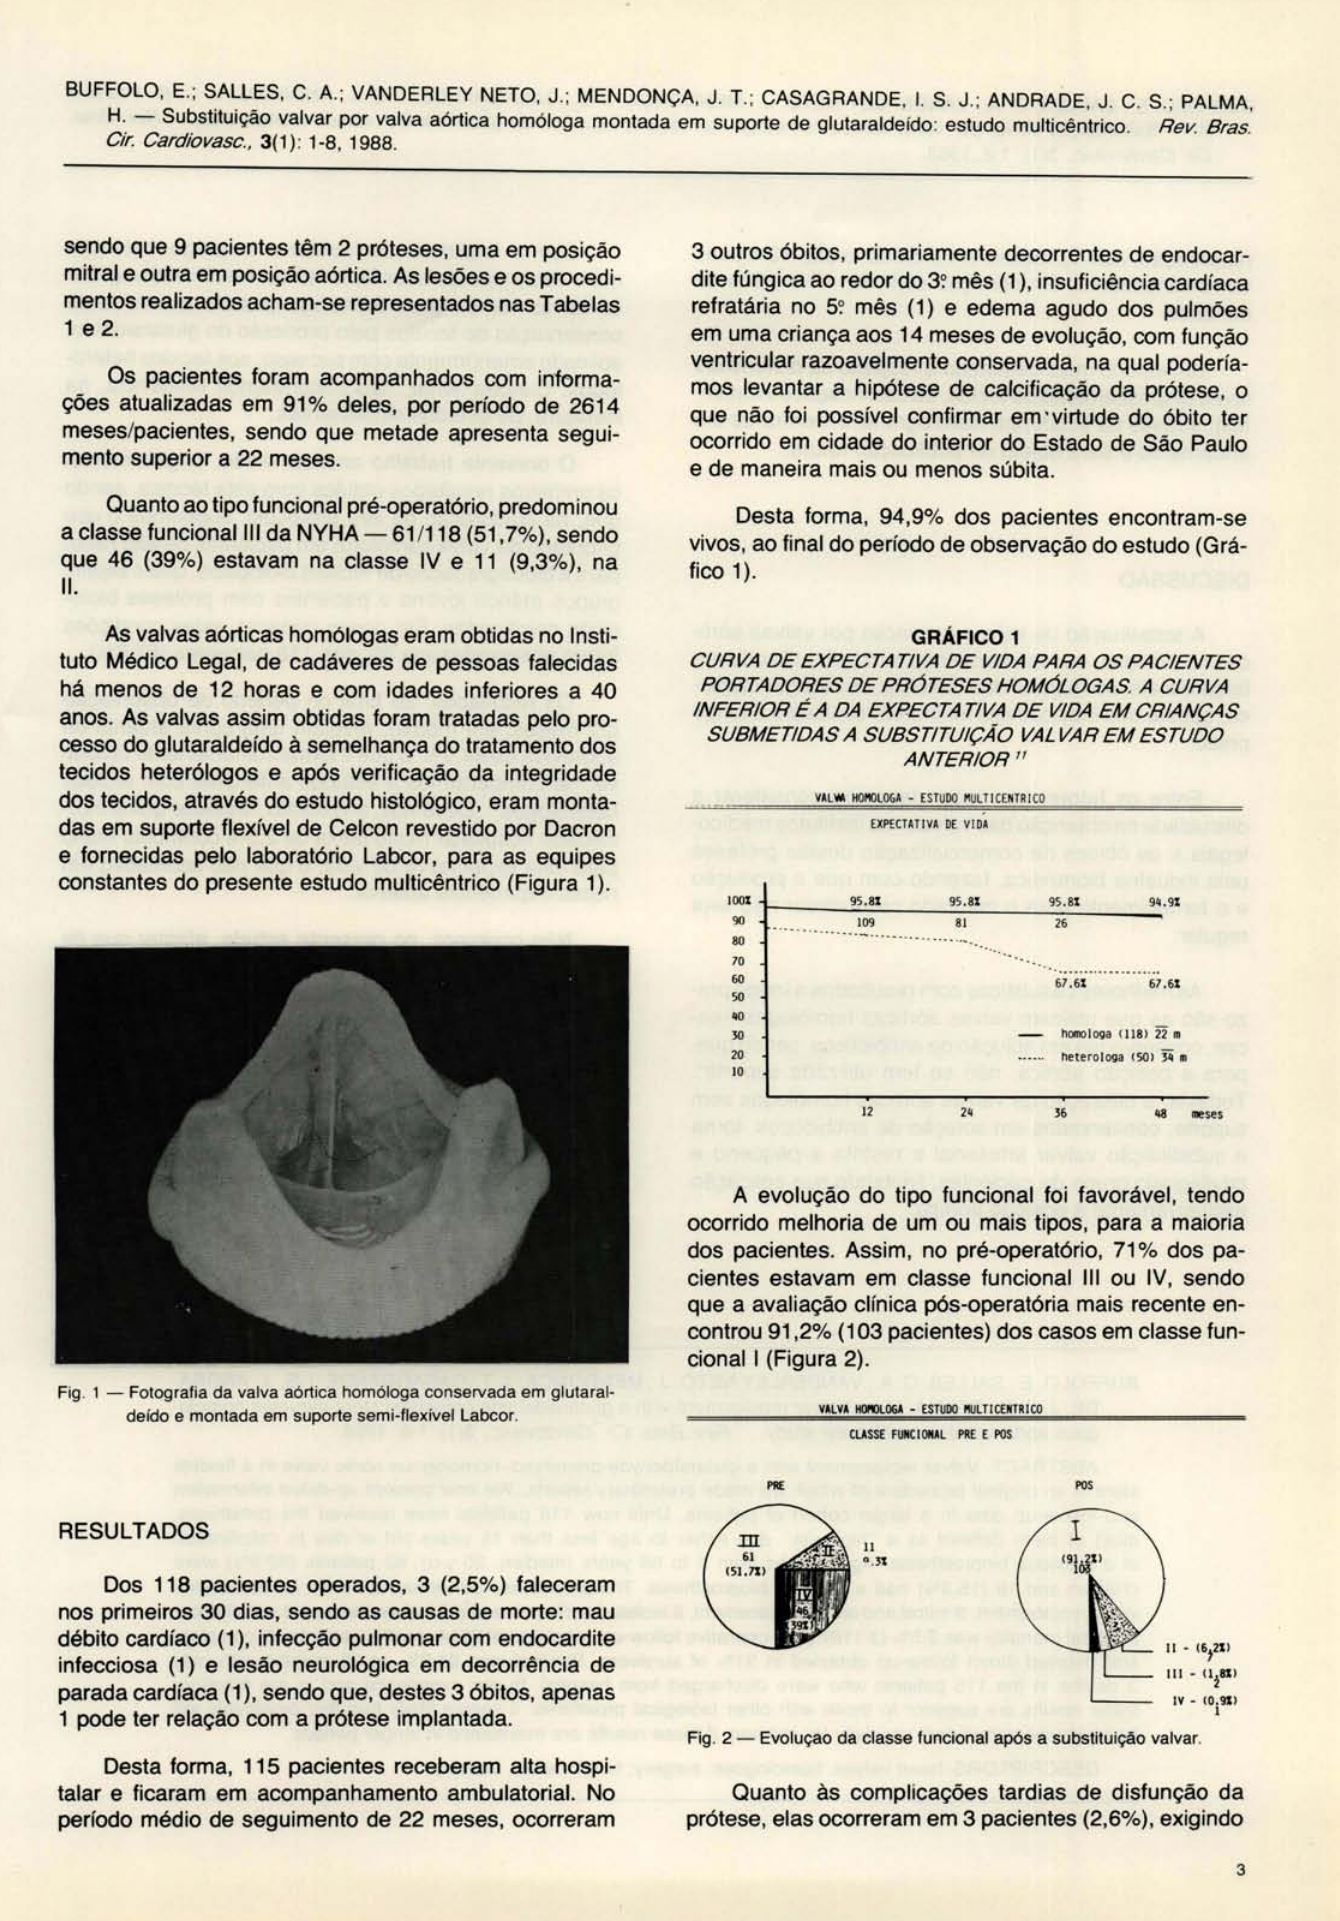
Fig. 2 - Evoluçao da classe funcional após a substituição valvar. Quanto às complicações tardias de disfunção